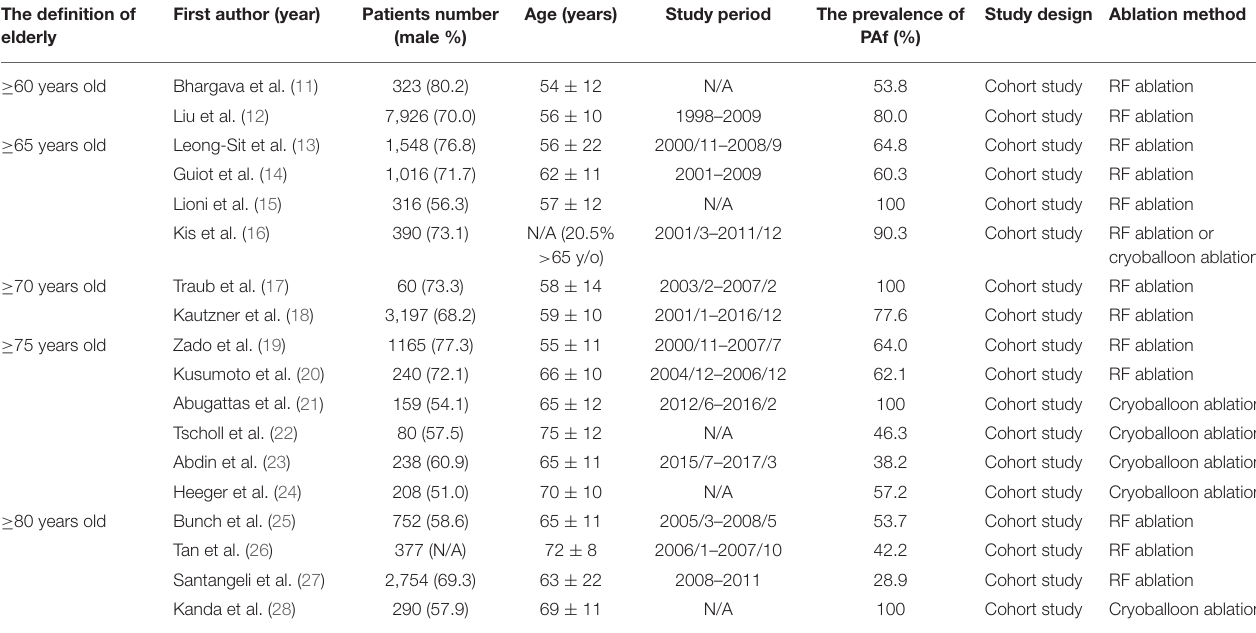
TABLE 1 | Characteristics of the 18 included studies.